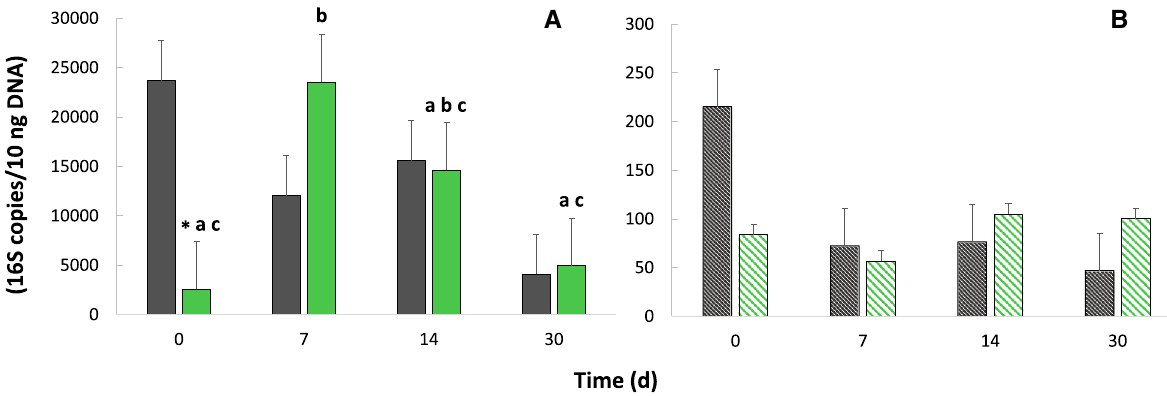
Figure 2. Mean number of 16S rRNA copies 10 ng −1 DNA for ( A ) Bacteria and ( B ) Archaea at the beginning of the incubation (T0) and after 7 (T1), 14 (T2) and 30 (T3) days. Gray color, control (non OPE-spiked sediments); green color, OPE-spiked sediments. * and letters: differences between treatments and time differences, respectively (p < 0.05).